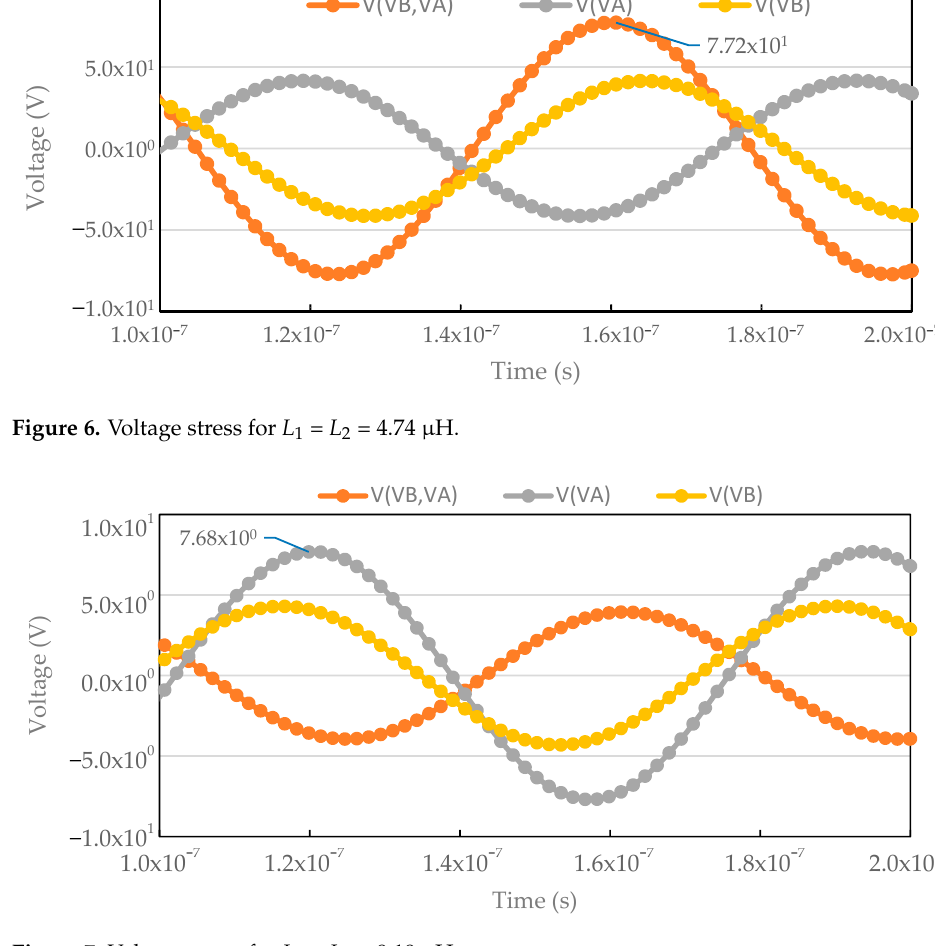
Figure 7. Voltage stress for L 1 = L 2 = 9.19 µH.